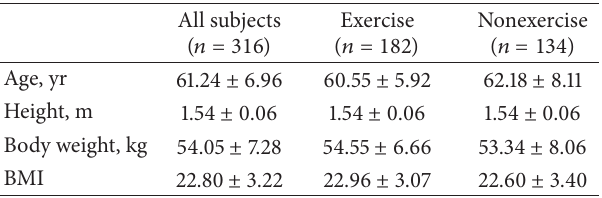
Table 1: Physical characteristics in the exercise and nonexercise